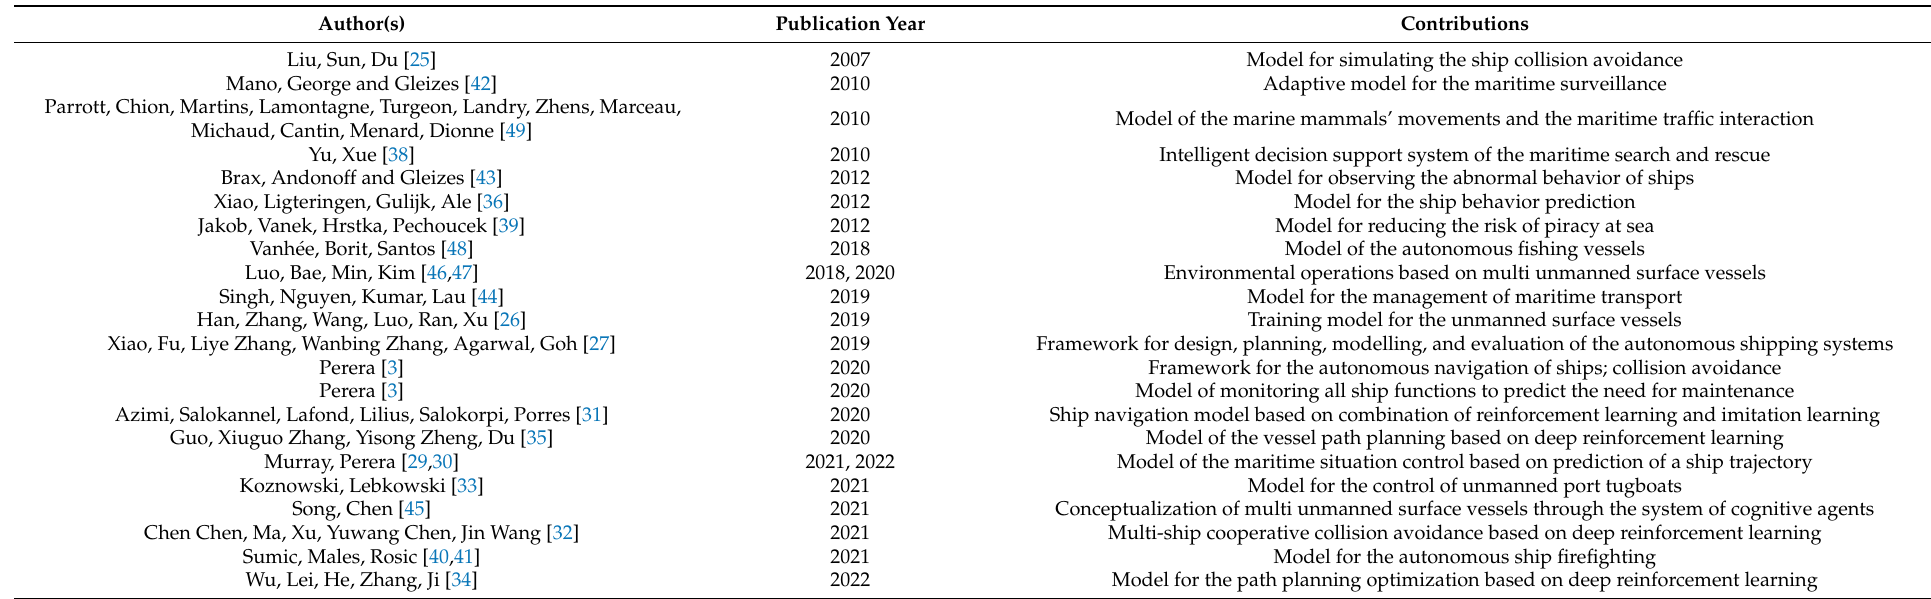
Table 1. Main contributions of the presented